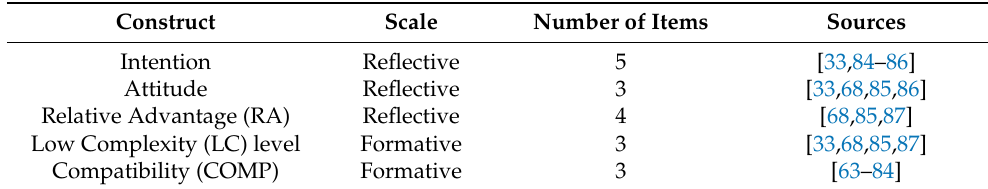
Table 1. Measurement scale of the